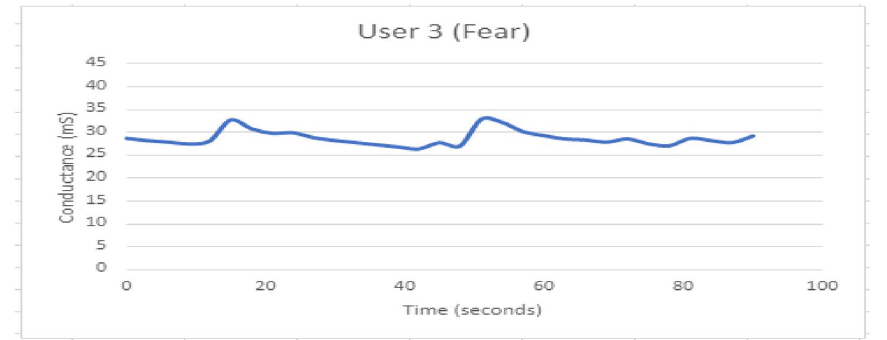
Fig. 16 GSR response when participant 3 is experiencing fear